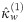
”Error-bar” plots of the Cohen’s kappa coefficient estimates (percent) for EXP1, bibliometric vs peer review ratings.The confidence intervals are at 95% confidence level and estimates corresponding to κ^w(1), κ^w(2) and κ^w(3) are in red, green and blue, respectively.